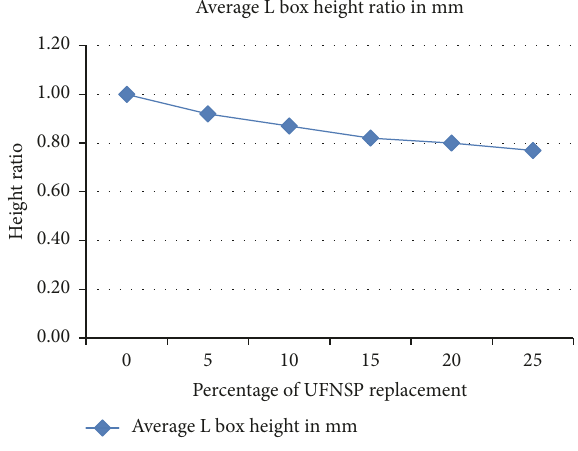
Figure 1: Results on 𝐿 box